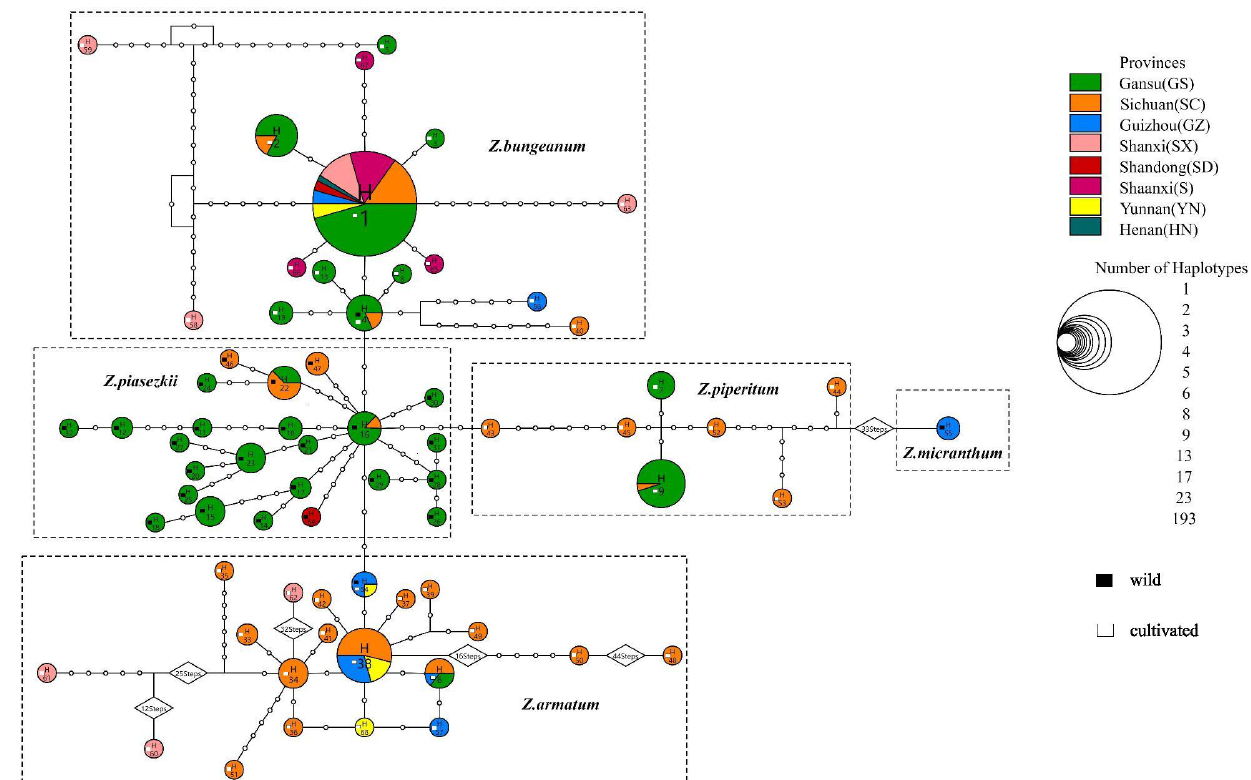
Figure 5. Median-joining network of 68 cpDNA haplotypes of Zanthoxylum